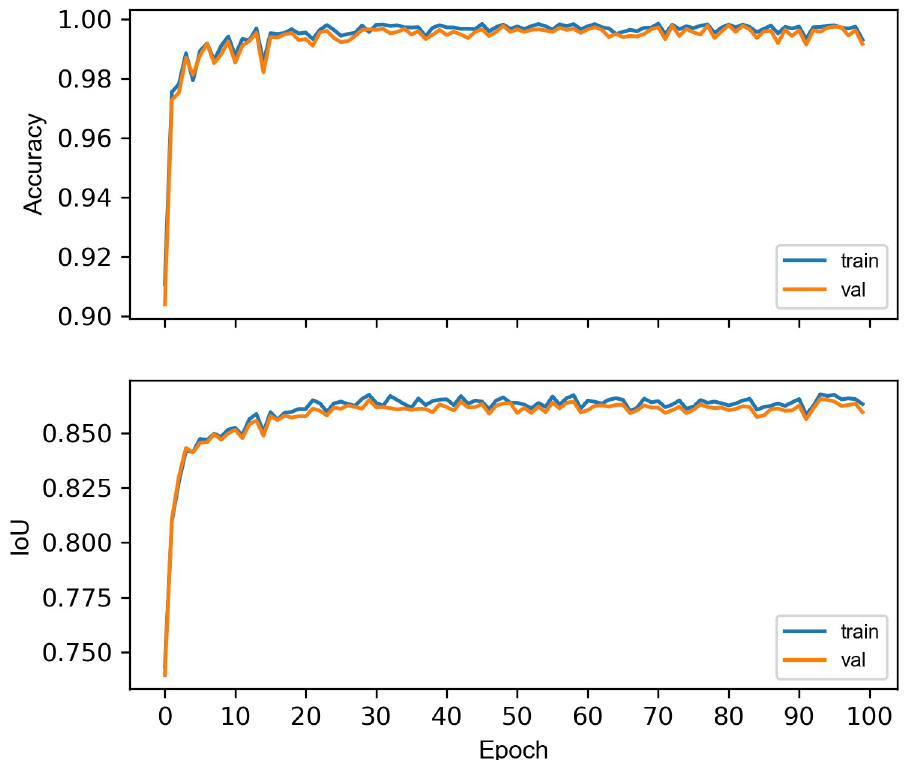
Fig 3. Training (train) and validation (val) mean accuracy and IoU scores for 10 fold cross-validation over the set of 5804 training images. Results suggest minimal overfitting to the training data however additional improvements to accuracy and IoU were limited after 30